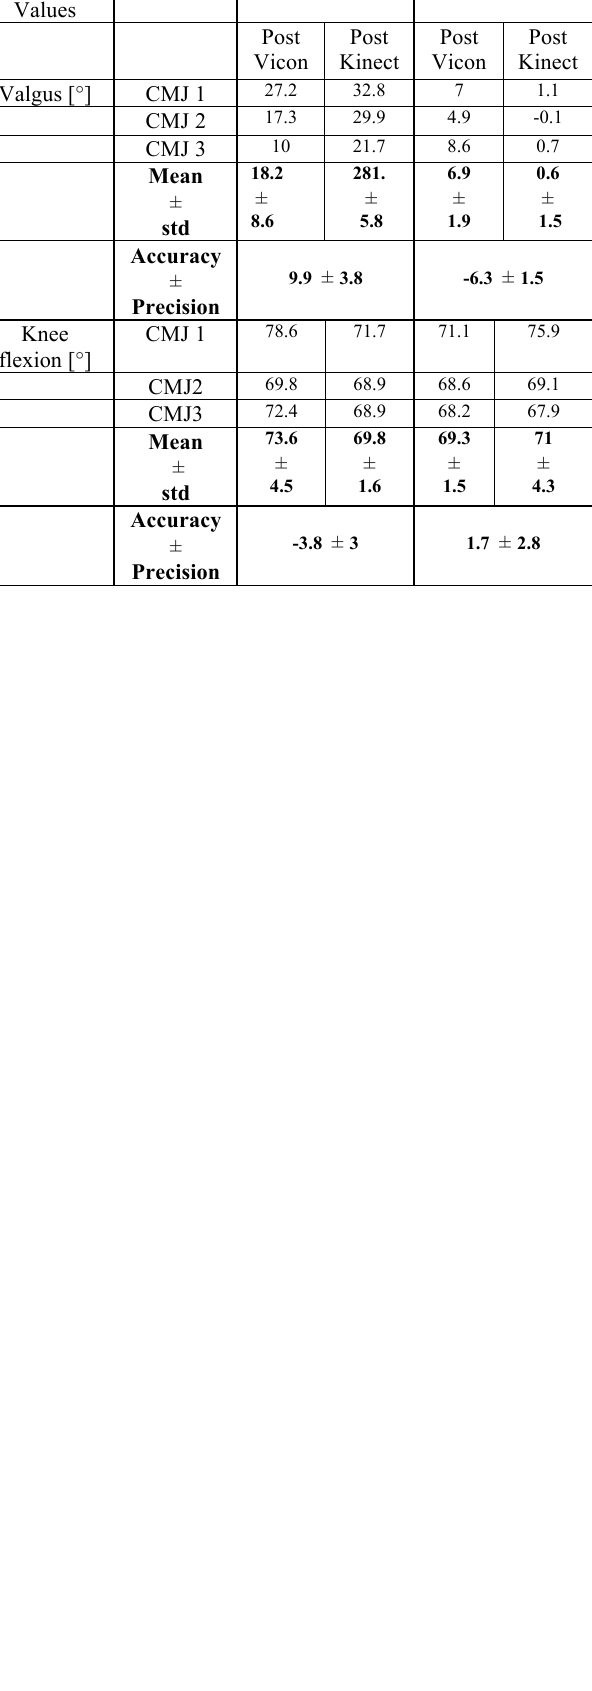
TABLE 2. Post Jump